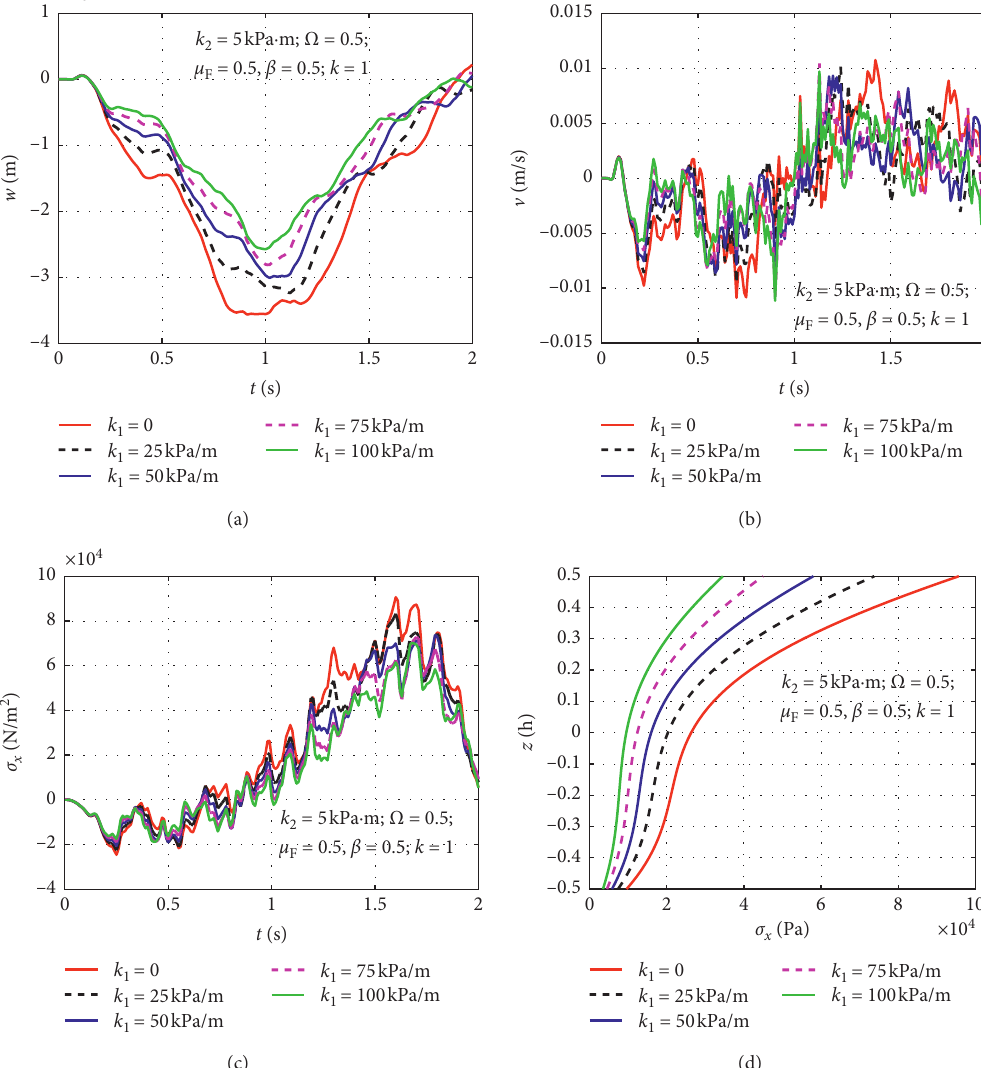
Figure 10: The responses of deflections, velocities, and stresses at the central point of the FGP plate versus time with the variation of the : (a) deflection w versus time; (b) velocity v versus time; (c) stress σ x versus time; (d) stress σ x through thickness. foundation stiffness k 1